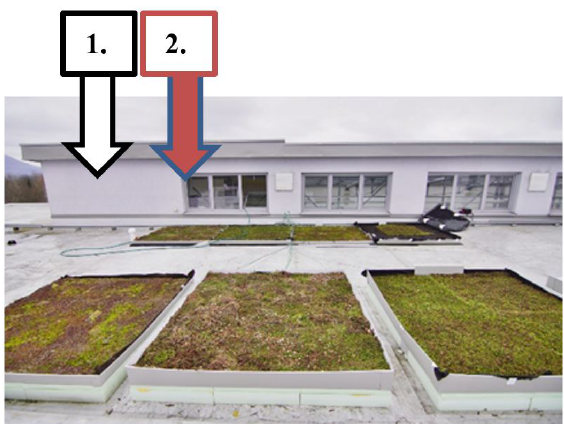
Figure 2. Front row for measuring the rainwater retention, the second one for temperature measure- ment (picture from autumn 2020). Marked position of compared compositions in this paper.